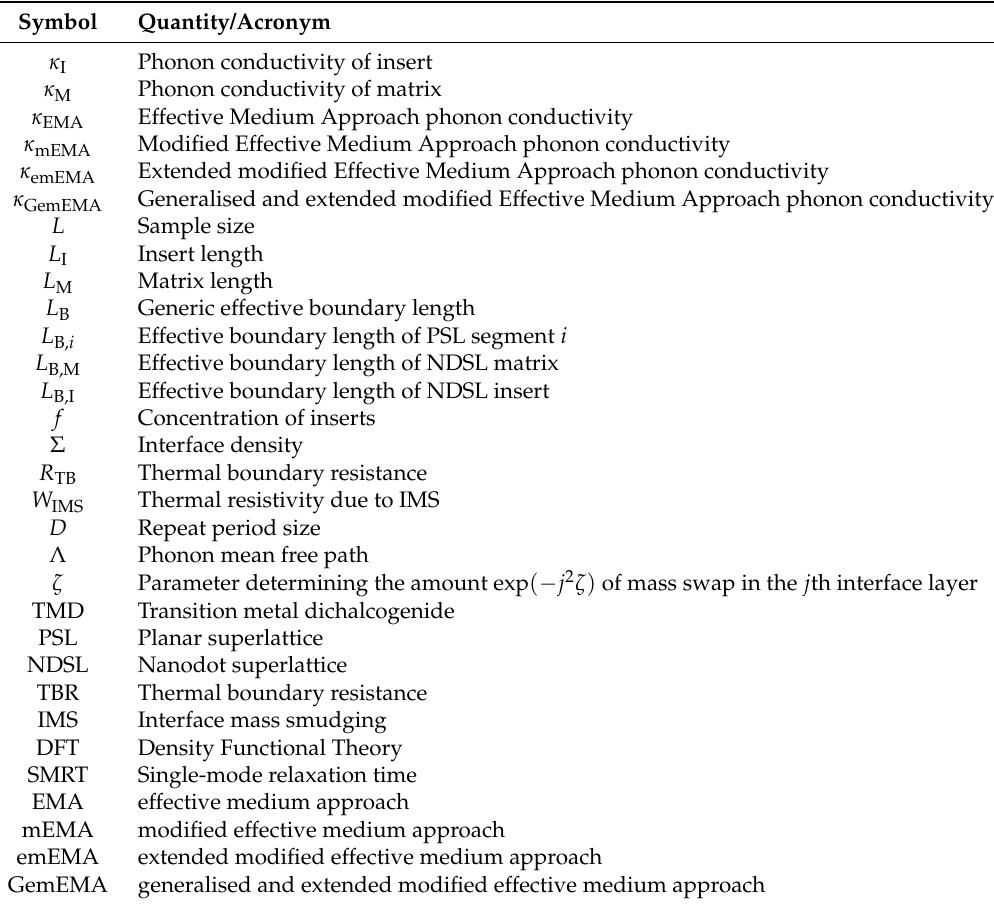
Table 1. Table of important quantities and